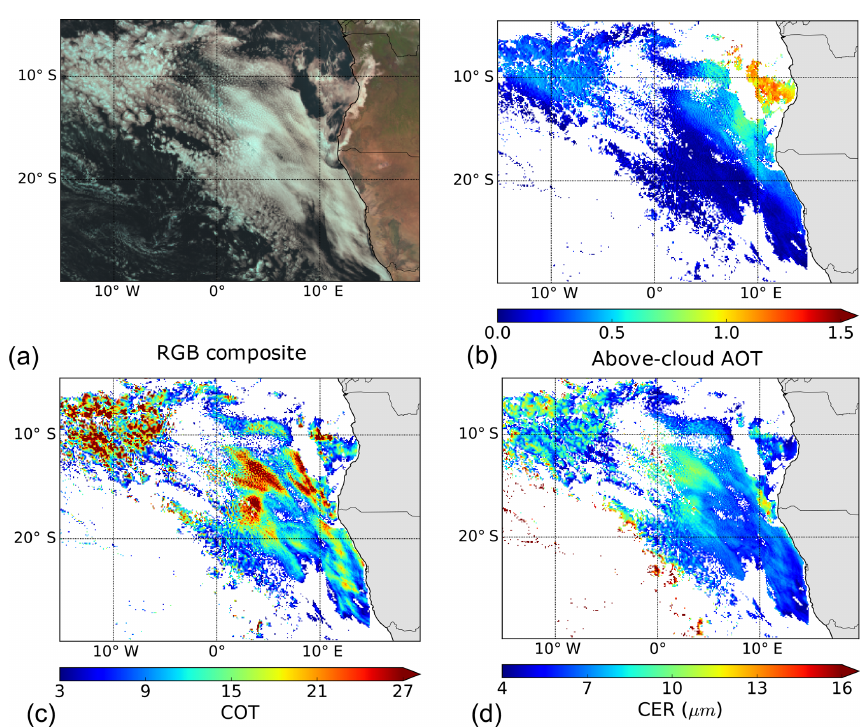
Figure 5. RGB composite (a) , above-cloud AOT at 0.55µm (b) and cloud properties ( c and d ) retrieved from SEVIRI measurements on 28 August 2017 at 10:12UTC over the SEAO.